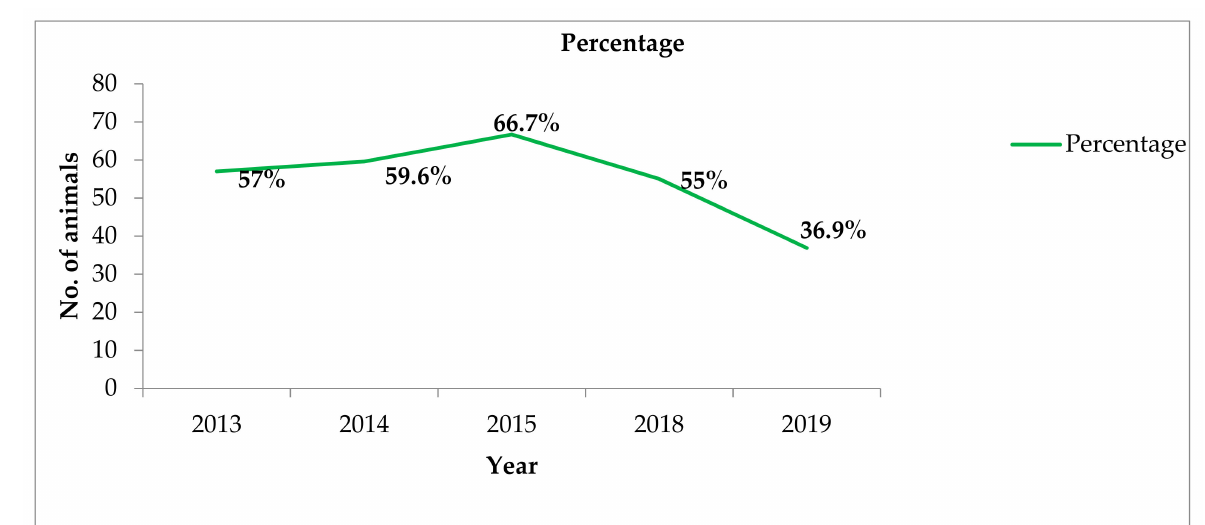
Figure 2. Proportion of antibiotic use among animals receiving care from the Kintampo Municipal Veterinary Clinic in Ghana stratified by year, 2013–2019. The clinic changed location in 2019 and records for 2016 and 2017 were lost, thus data were not available for review.